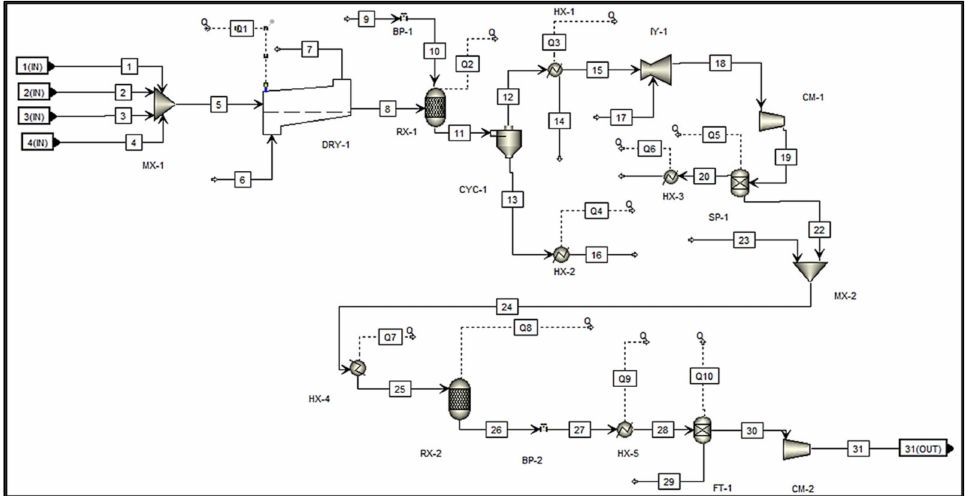
Figure 2. Process flowsheet diagram of the gasification process. Table 1. Chemical composition and mass flow rate of raw materials in the gasification process.